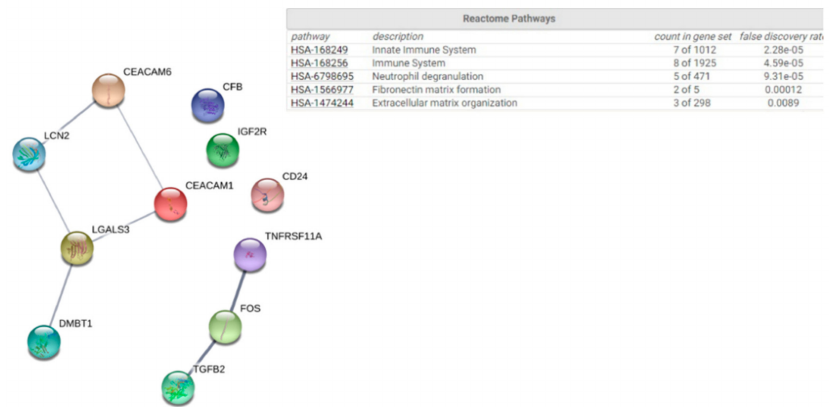
Figure 3. PPI of immune DEGs between responders and non-responders in nasal lavage following supplementation. Genes were clustered by